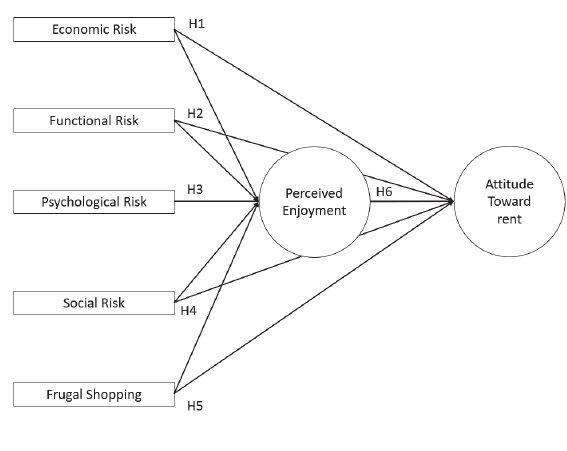
Fig. 4. Research Model Source: Researchers Data (2019)